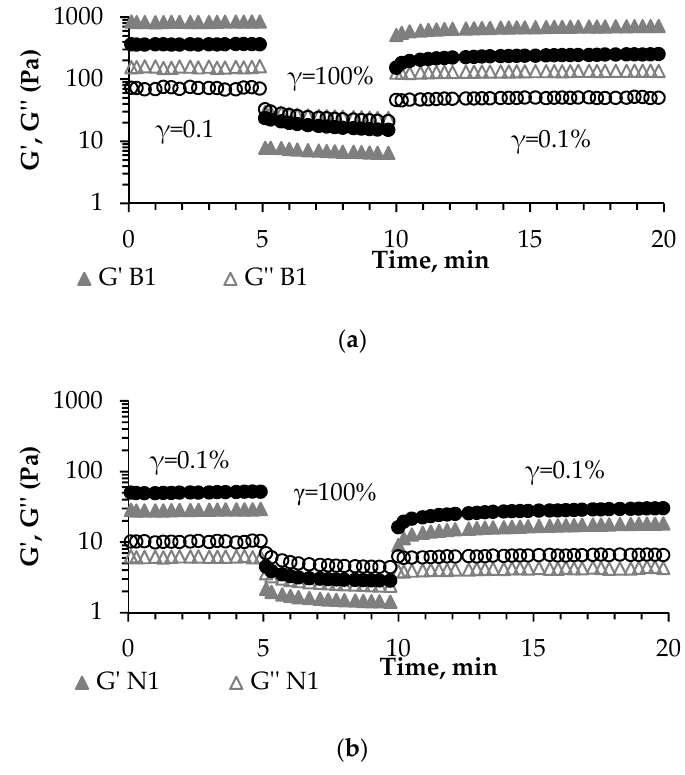
Figure 2. Structure recovering ability of ( a ) broad bean- and ( b ) chickpea-based fermented products determined with 3ITT under low-amplitude oscillatory conditions. B1—broad bean-based product fermented with SC1; B2—broad bean-based product fermented with SC2; Ch1—chickpea-based product fermented with SC1; Ch2—chickpea-based product fermented with SC2.